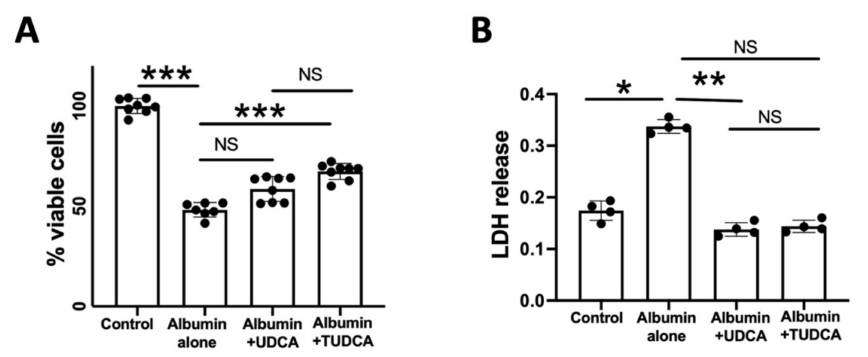
Figure 1. UDCA and TUDCA protect from albumin-induced cell death in vitro. ( A ) The % of viable cones cells decreased with albumin (20 mg/mL) but was higher when cones received 1 µ M of UDCA or TUDCA, with only significance for TUDCA. No significantly difference was seen between UDCA and TUDCA. ( B ) LDH release was increased by albumin. Treatment by UDCA or TUDCA decreased LDH release, with only significance for UDCA. No significant difference was seen between UDCA and TUDCA treatment outcomes. The results are presented as the means ± SEM, n = 4–8, Kruskal–Wallis and Dunn’s multiple comparisons post hoc test (* p < 0.05; ** p < 0.01, *** p <